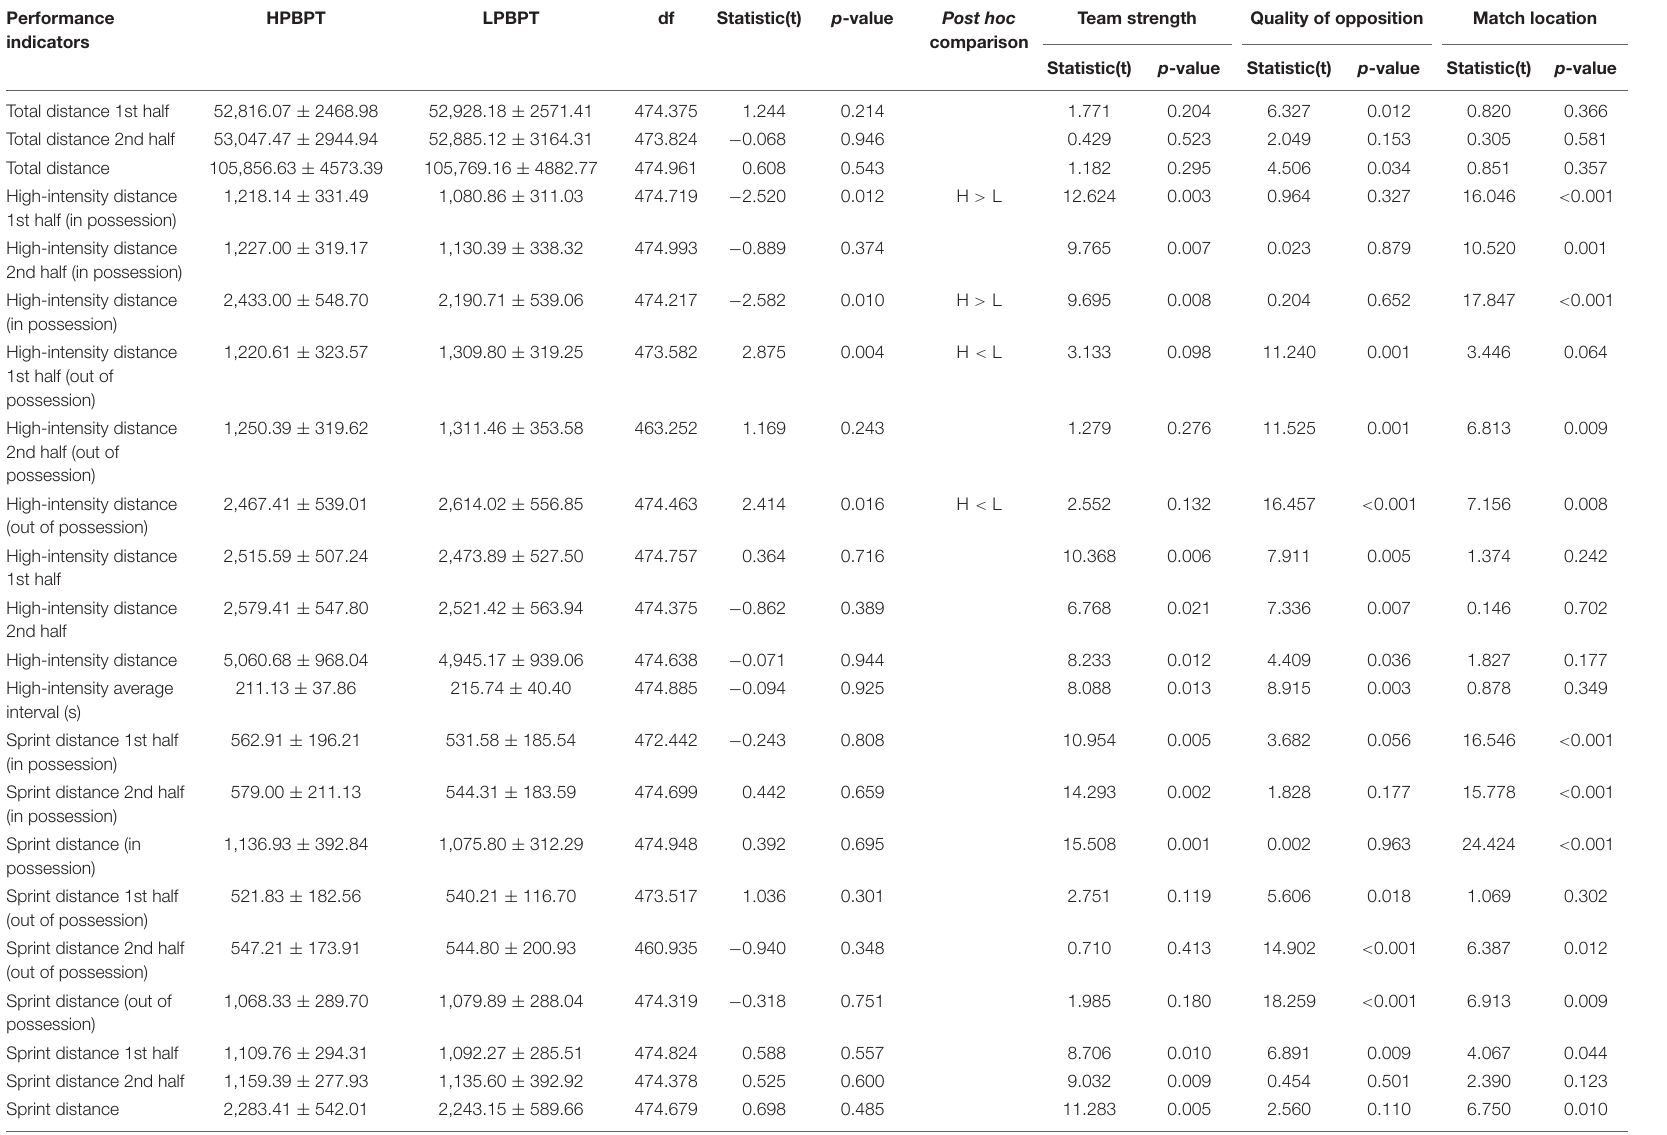
TABLE 2 | Difference of running performance between HPBPT and